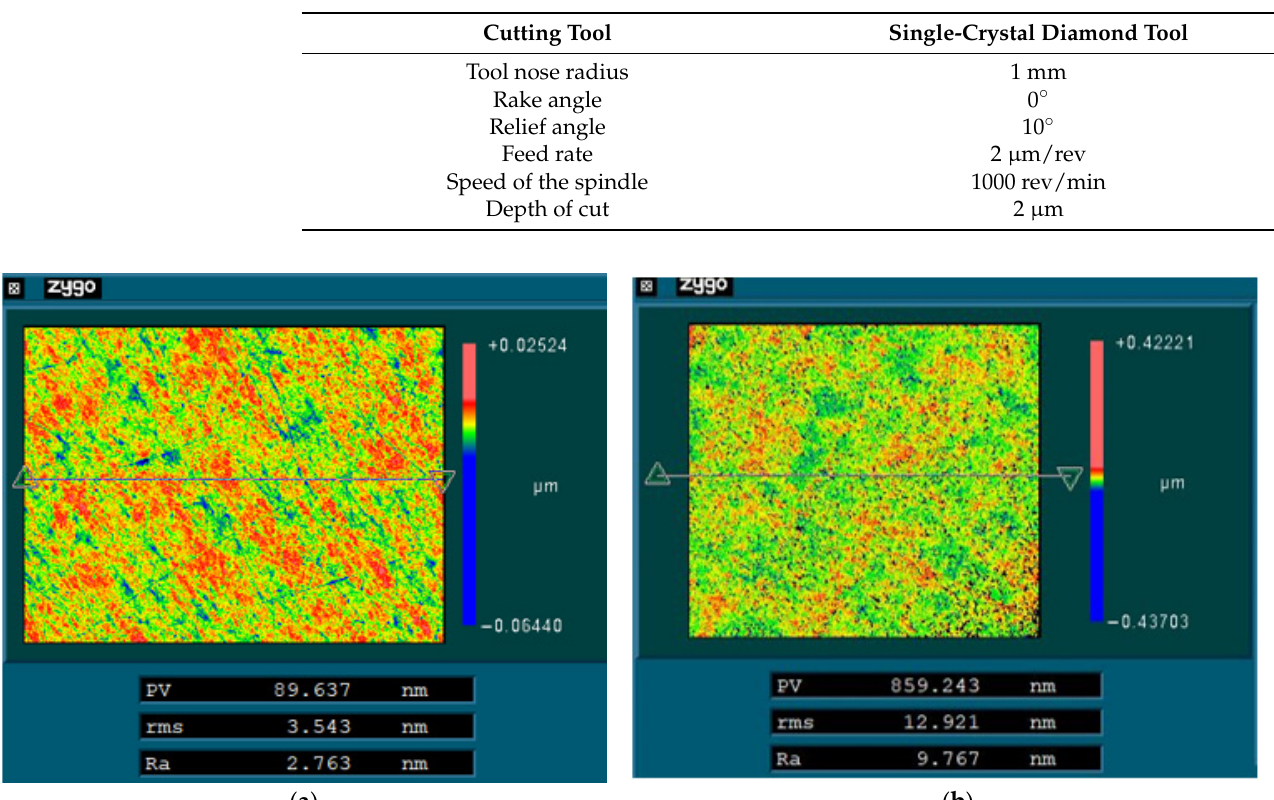
Table 3. Cutting parameters in SPDT.